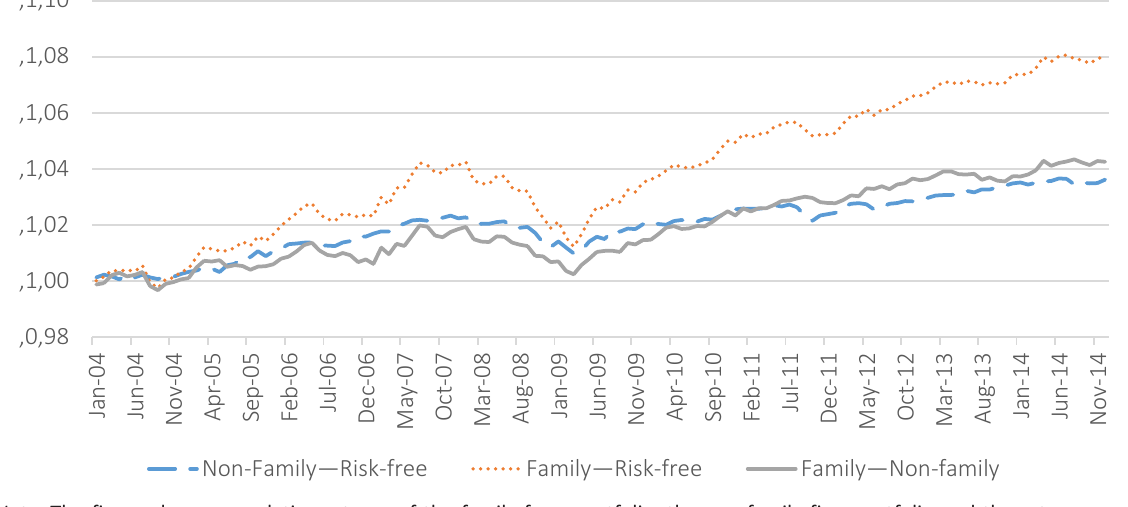
Figure 2. Value weighted portfolios (buy-and-hold